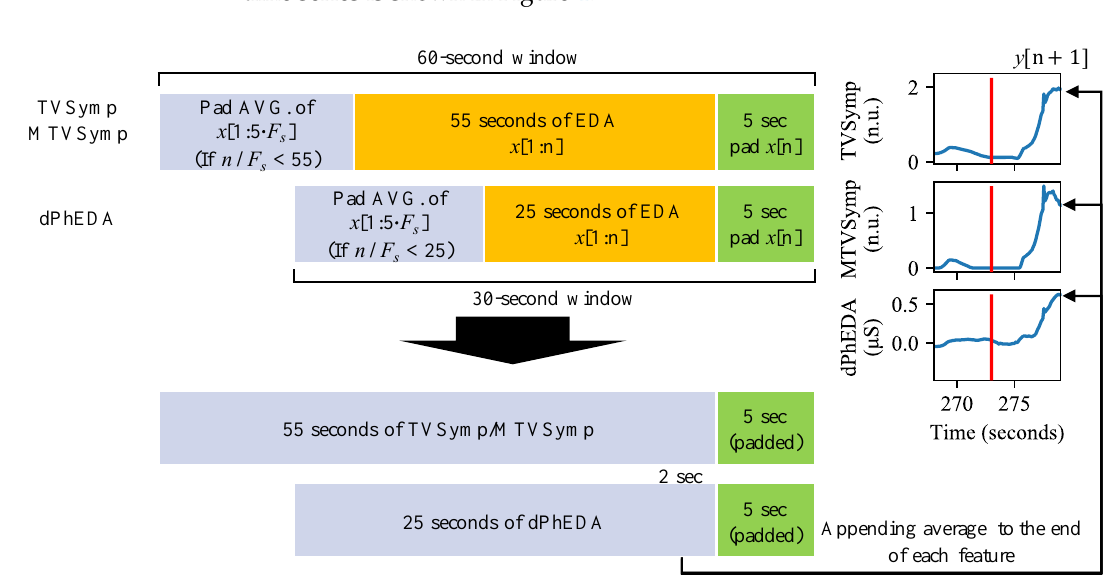
Figure 3. Objective real-time pain measuring scheme. The red bars in the signals represent where a stimulus was given. F s : sampling frequency (2 Hz).